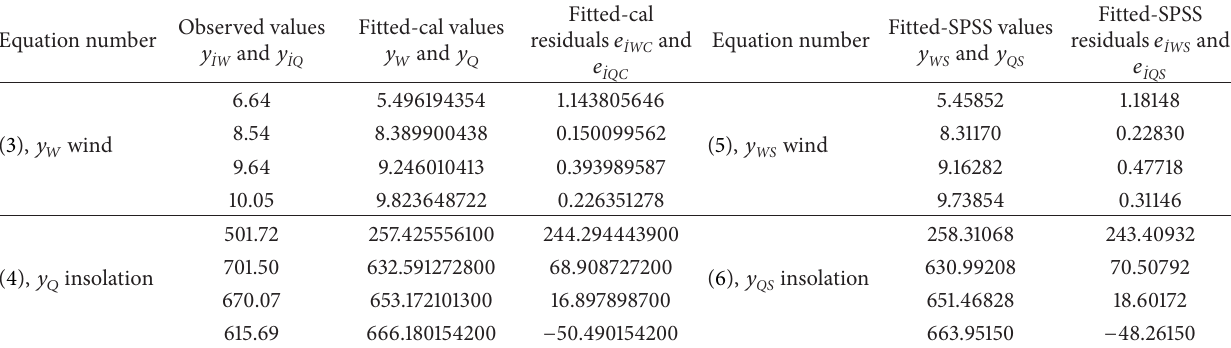
Table 8: The future estimation results obtained using the dependent variables, regression equations of wind speed, and insolation level data. Observed values Equation number 𝑦 𝑦 ˙IW and